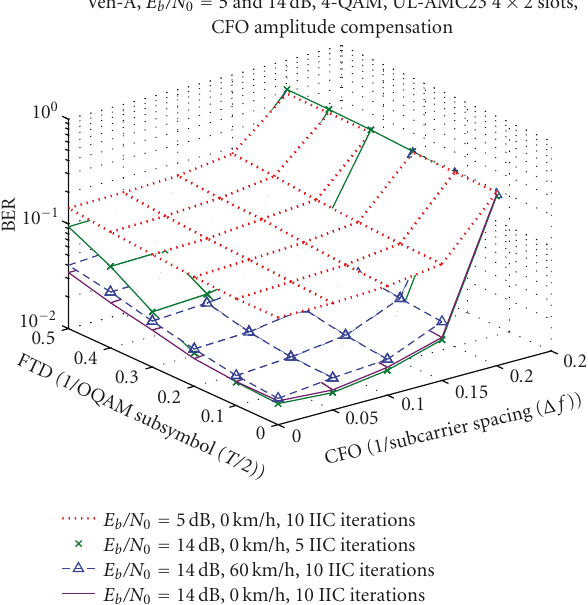
Figure 14: BER performance versus CFO and FTD of the IIC joint FTD and channel estimation method in di ff erent channel scenarios. 4-QAM transmission of 4 × 2 AMC23 slots in Vehicular-A channel at E b /N 0 = 5dB and E b /N 0 = 14 dB and at di ff erent velocities. 5 and 10 iterations in the IIC technique. No additional synchronization